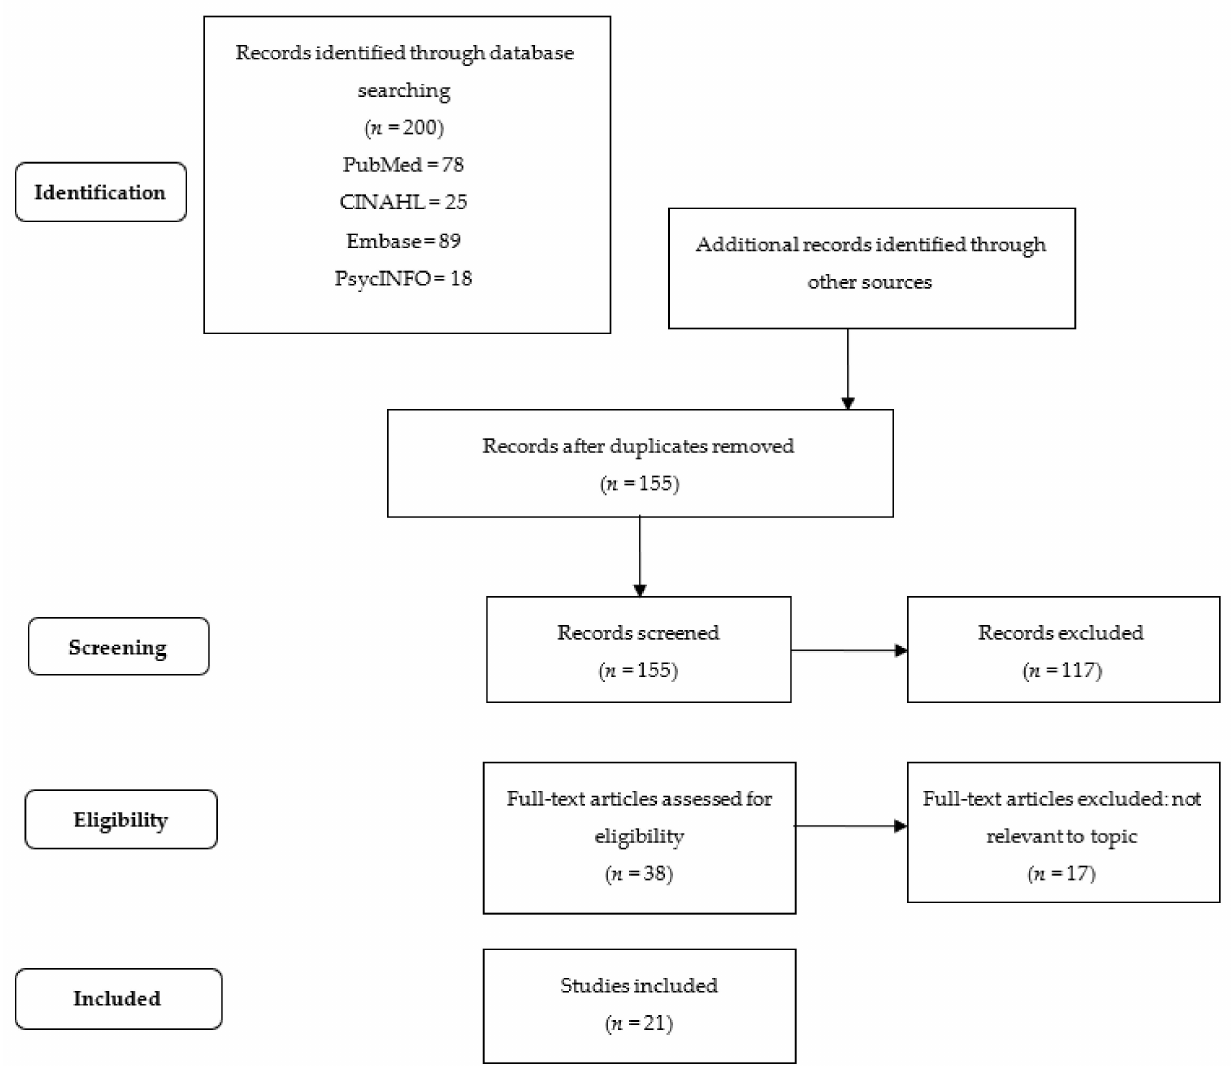
Figure 1. Workflow diagram of the search and selection process, based on the PRISMA